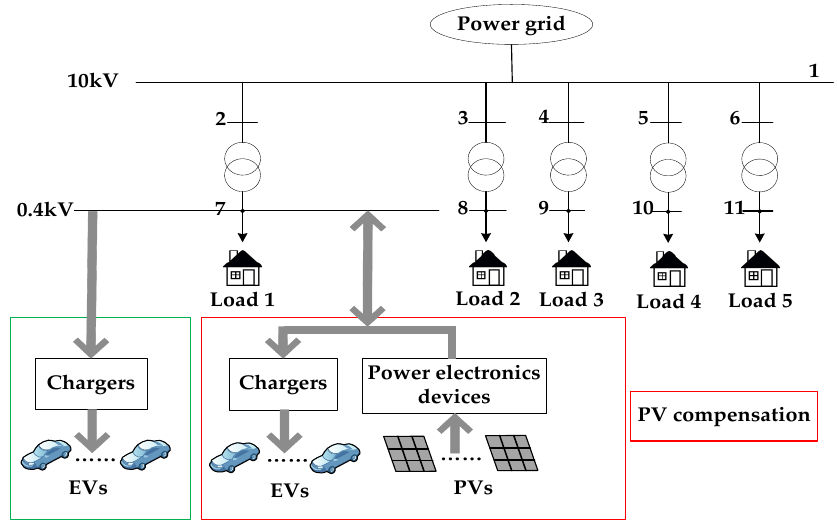
Figure 4. Structure of distribution grid.